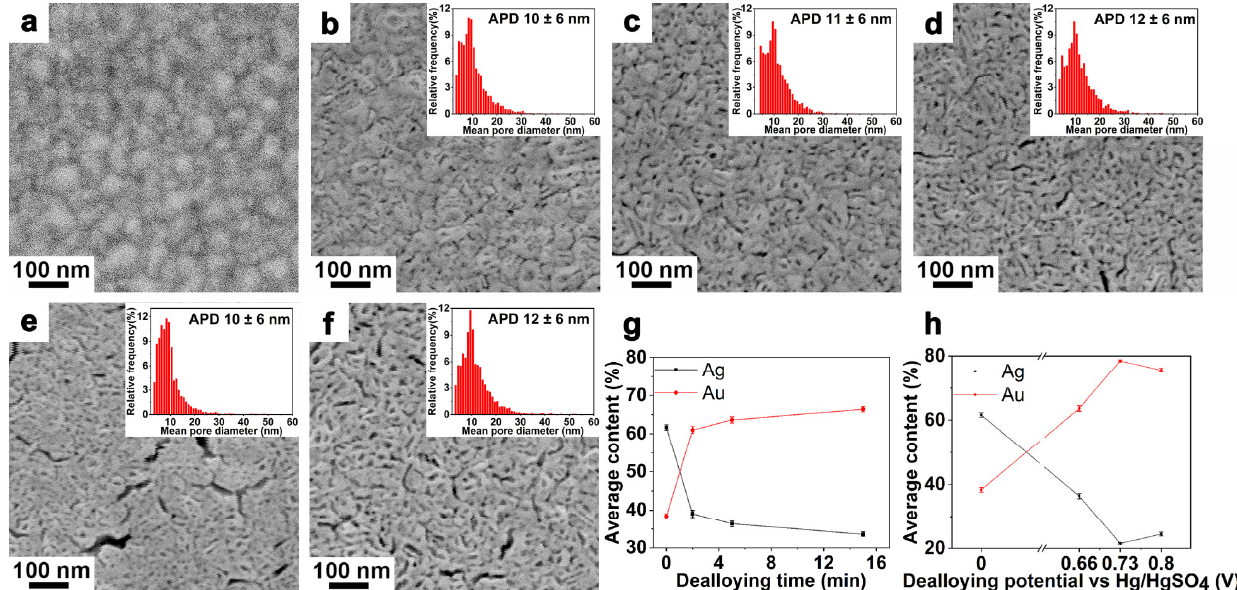
Figure 2. SEM images and composition variation of the dealloyed samples. ( a ) SEM image of the Au-Ag film. ( b – f ) SEM images of the 1#–5# samples with the statistical analysis of the pore diameter in the insert, respectively. ( g ) Composition variation of the dealloyed sample against the dealloying time. ( h ) Composition variation of the dealloyed sample against the dealloying potential.